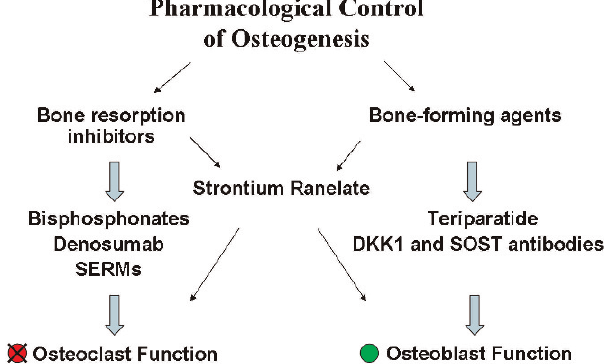
Figure 2 - Summary of the main drugs used in the control of